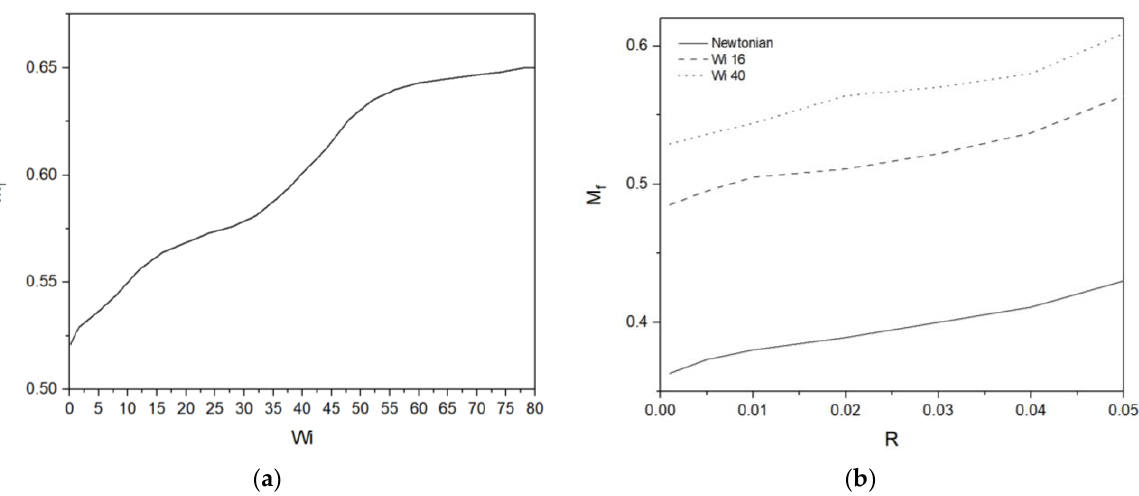
Figure 5. ( a ) Migration distance of droplets for different Wi ; ( b ) Migration distance of droplets with different initial radius.